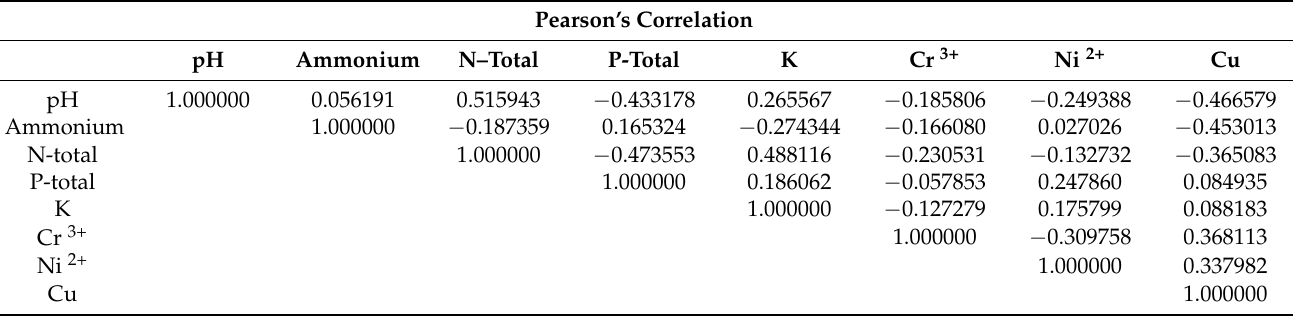
Table 5. Results of the correlation between nutrients and heavy metals in agricultural soils. Pearson’s